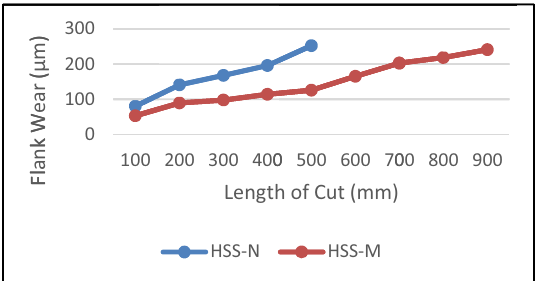
Table 1: Experimental conditions Figure 3: Flank wear graph according to experimental results.